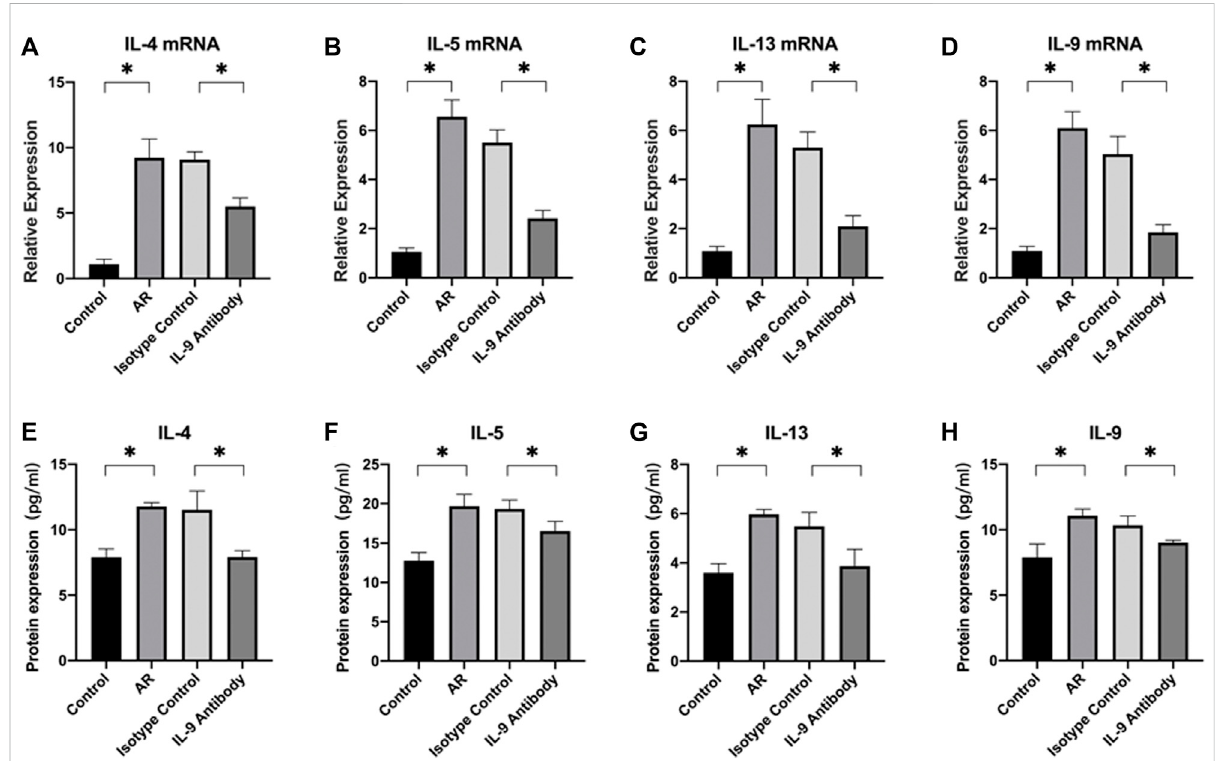
FIGURE 2 Expression of cytokines and their mRNA in nasal mucosa of mice in each group (A) – (D) The mRNA expressions levels of cytokines in nasal mucosa which were determined by real-time PCR. After total RNA was extracted, it was reverse transcribed into cDNA, and then real-time PCR was performed to obtain the Ct value of each gene. We used 2 − ΔΔ Ct to calculate the relative expressions. β -actin was used as the internal control. ΔΔ Ct = [ Δ Ct (Ct value of target gene in experiment group-Ct value of β -actin)- Δ Ct (Ct value of target gene in control group- Ct value of β -actin)]. Each group repeats fi ve independent samples, and each independent sample repeats three times to take the mean value. One way ANOVA/Tukey was used for statistical analysis. All results were mean ± SEM. * p < 0.05. (E) – (H) The protein expression of IL-4, IL-5, IL-13, and IL-9 in nasal mucosa